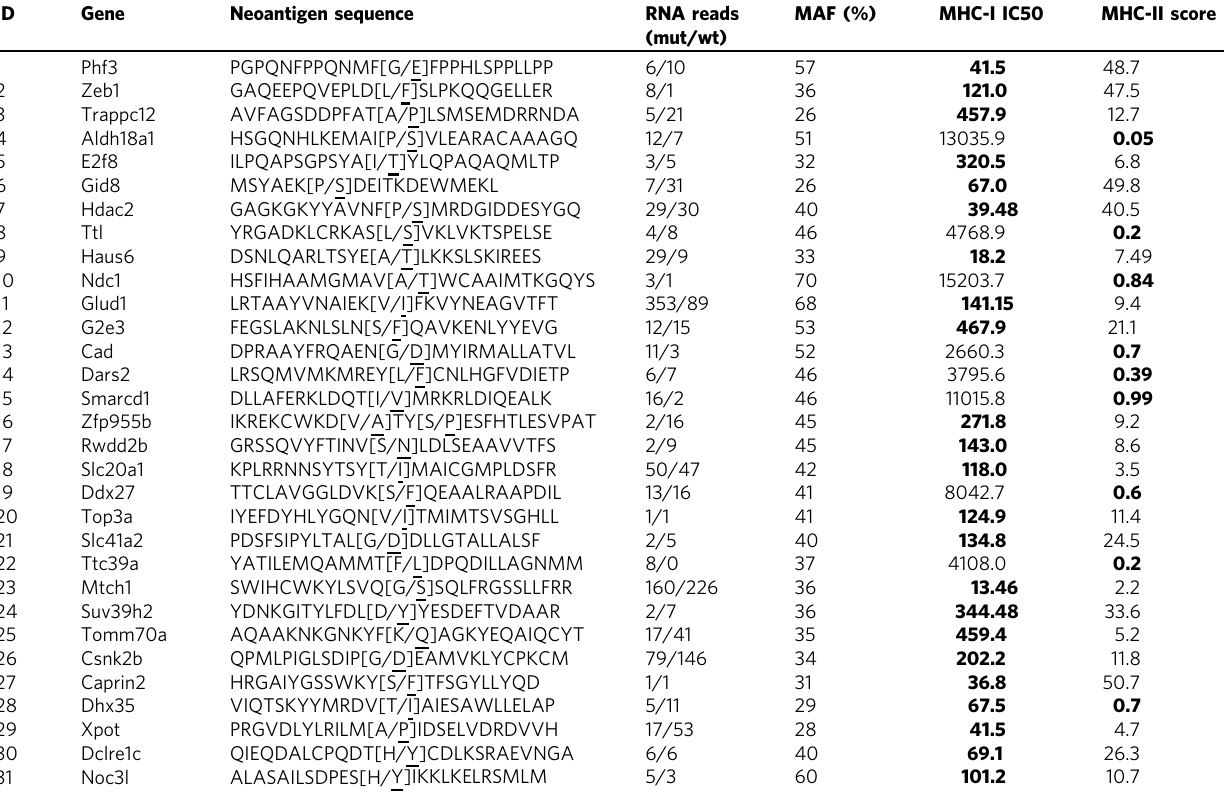
Table 1 CT26 neoantigens encoded by GAd-CT26-31